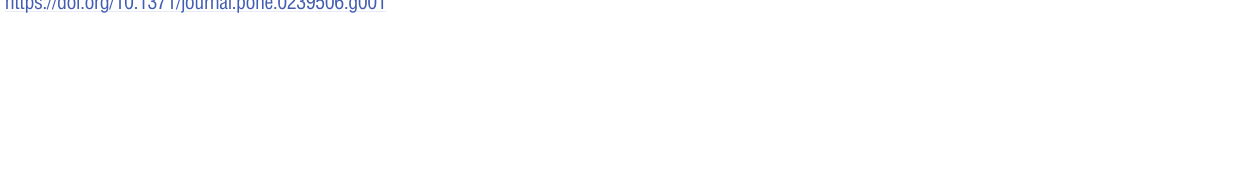
PLOS ONE | https://doi.org/10.1371/journal.pone.0239506 September 25,